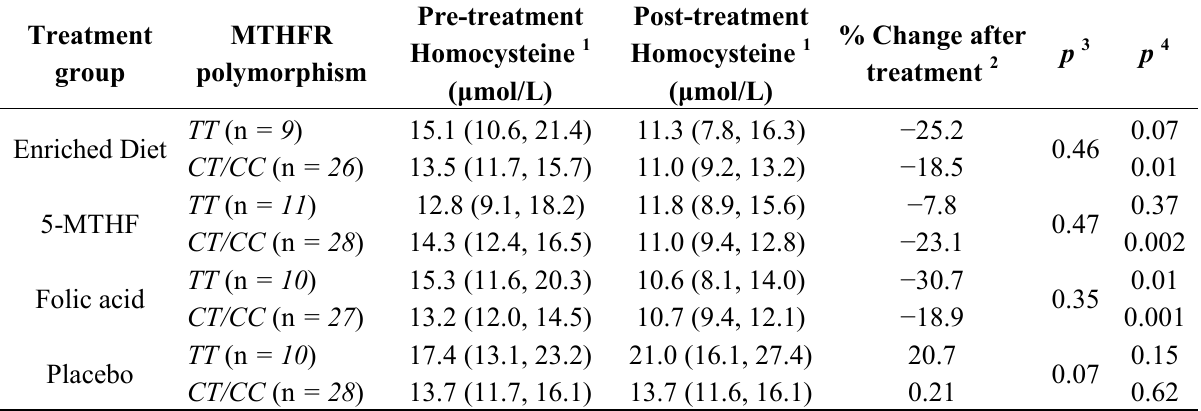
Table 4. Distribution of Hcy levels before and after the intervention according to treatment groups and MTHFR